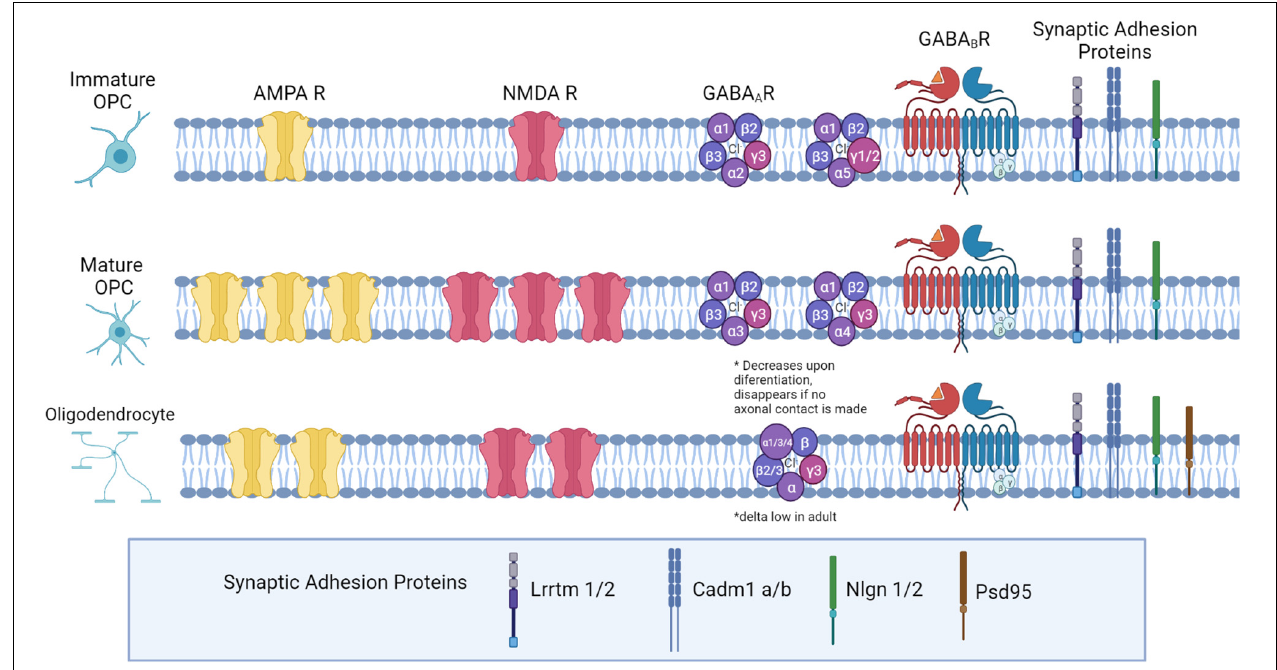
FIGURE 1 | Neurotransmitter receptor expression and synaptic adhesion protein expression across the Oligodendrocyte lineage. In immature OPCs (PO-P9), AMPA and NMDA receptors are present at low densities, with expression peaking later in development (P10-P35). As OPCs mature into OLs, they express fewer AMPA and NMDARs. GABAA receptor subunit expression changes: in early development, α 1, α 2, and α 5 subunits are highly expressed. Later in development, α 2 and α 5 decrease expression, and α 3 and α 4 both increase in expression. β 2 and β 3 expression is high, and does not change during maturation, while β 1 declines from low to very low expression in OPCs later in development. The δ subunit is not present in development but is expressed in a small percentage of OPCs in adulthood. All γ subunits are expressed in OPCs: γ 3 is highly expressed and maintained throughout development, but γ 1 and γ 2 are highly expressed in OPCs early in development and decrease in adulthood. Both GABA B subunits are expressed consistently throughout development (GABA B 1 and GABA B 2 ). Both OPCs and mature OLs express the adhesion proteins Lrrtm1, Lrrtm2, Neuroligin 1, Neuroligin 2, Cadm1a, and Cadm1b, based on RNASeq expression analysis in OPCs, and based on LOF function analyses in OLs. Additionally, OLs express